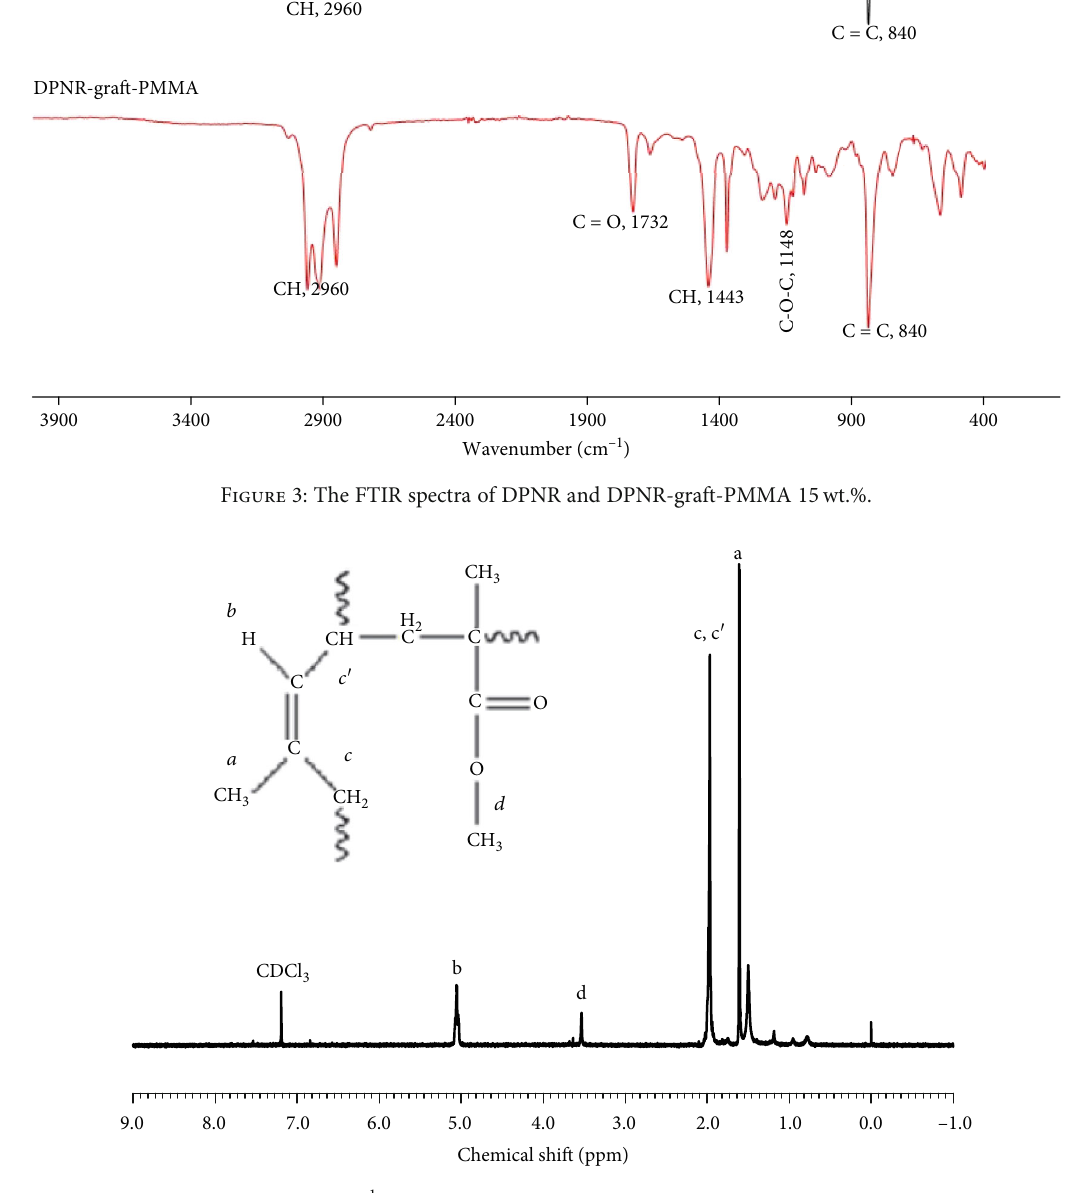
Figure 4: 1 H-NMR spectra of DPNR-graft-PMMA